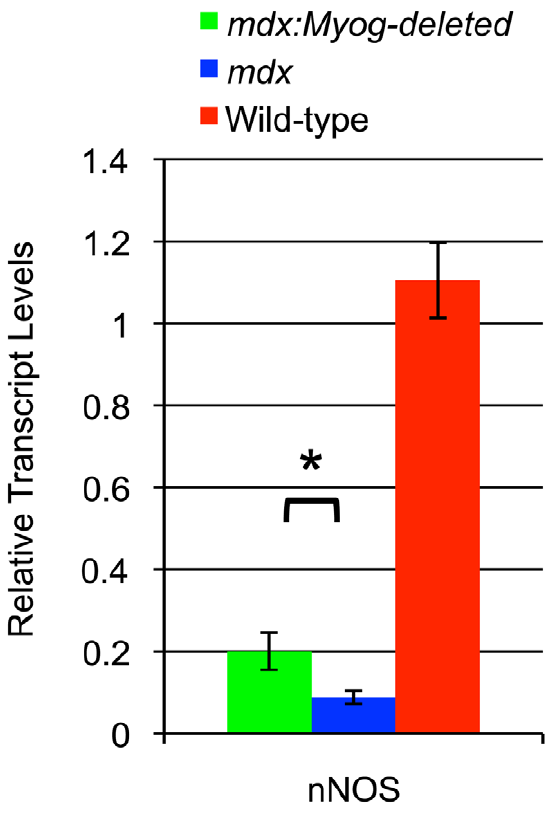
Figure 8. Altered expression of nNOS in mdx , mdx:Myog - deleted, and wild-type hindlimb muscle. RT-qPCR analysis demonstrated that transcript levels of nNOS were reduced in mdx mice (n=3). Expression of nNOS was increased 2.2-fold in mdx:Myog - deleted mice (n=3) compared to that in mdx mice. Error bars represent 1 standard deviation (* p ,